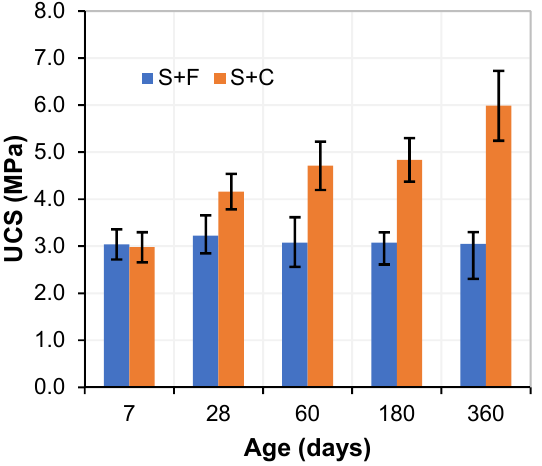
Figure 8. UCS for soil stabilized with WPFA or cement.